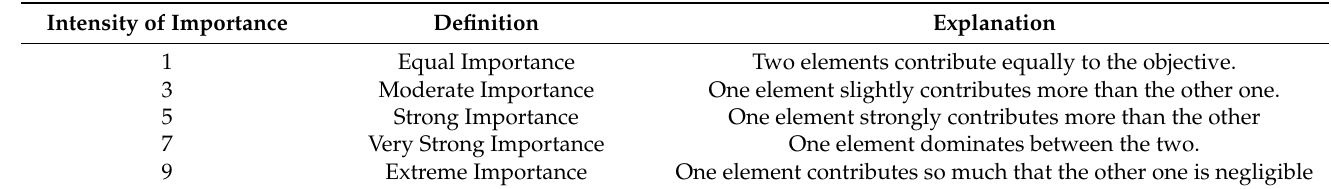
Table 2. Scale for pairwise comparisons. Intensities of 2 4, 6, and 8 are used to express intermediate